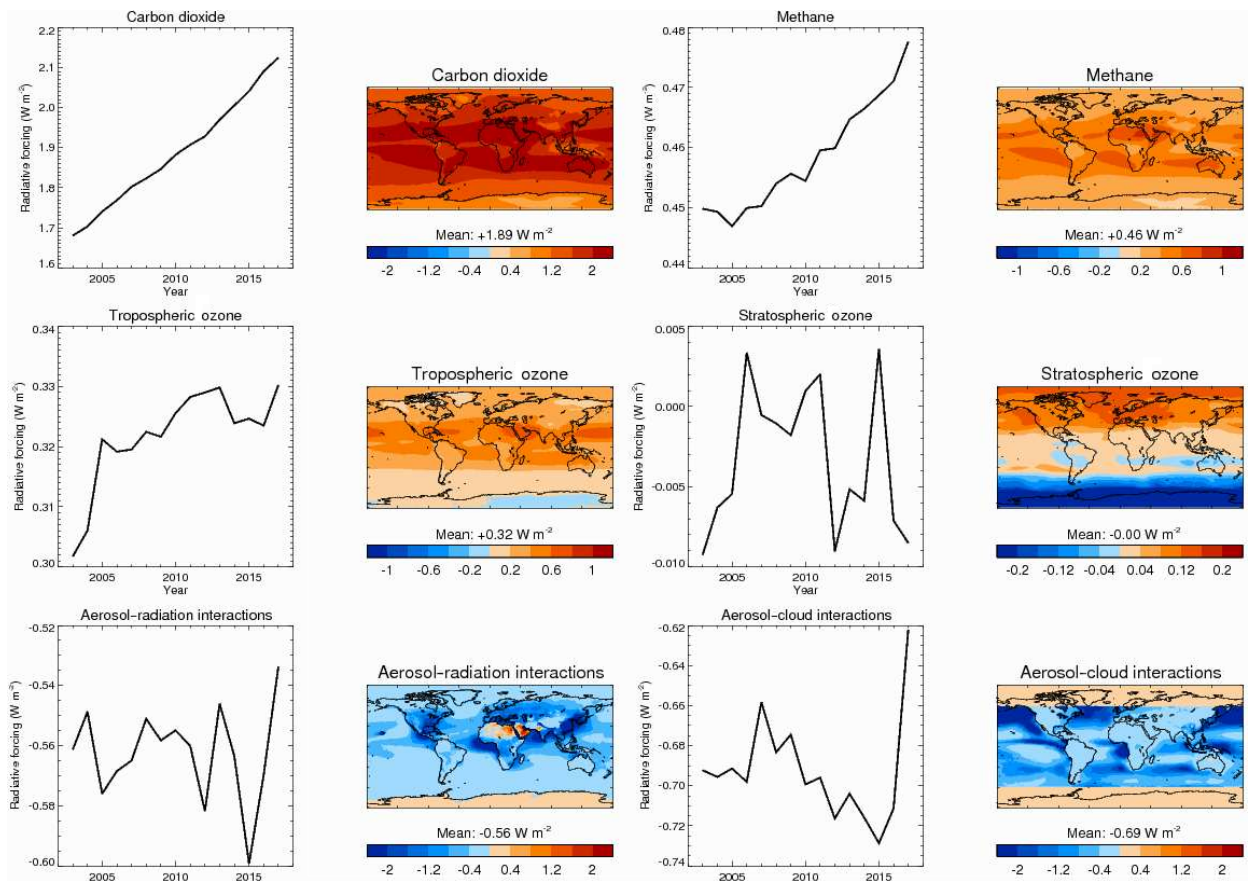
Figure 10. Annual and global-mean time series and average distribution for the CAMS reanalysis period 2003–2017 of the stratospherically adjusted radiative forcing (relative to 1750 in Wm − 2 ) of carbon dioxide, methane, tropospheric ozone, stratospheric ozone, aerosol–radiation interactions, and aerosol–cloud interactions. Radiative forcing is given for shortwave plus longwave, except for aerosols where it is given for shortwave